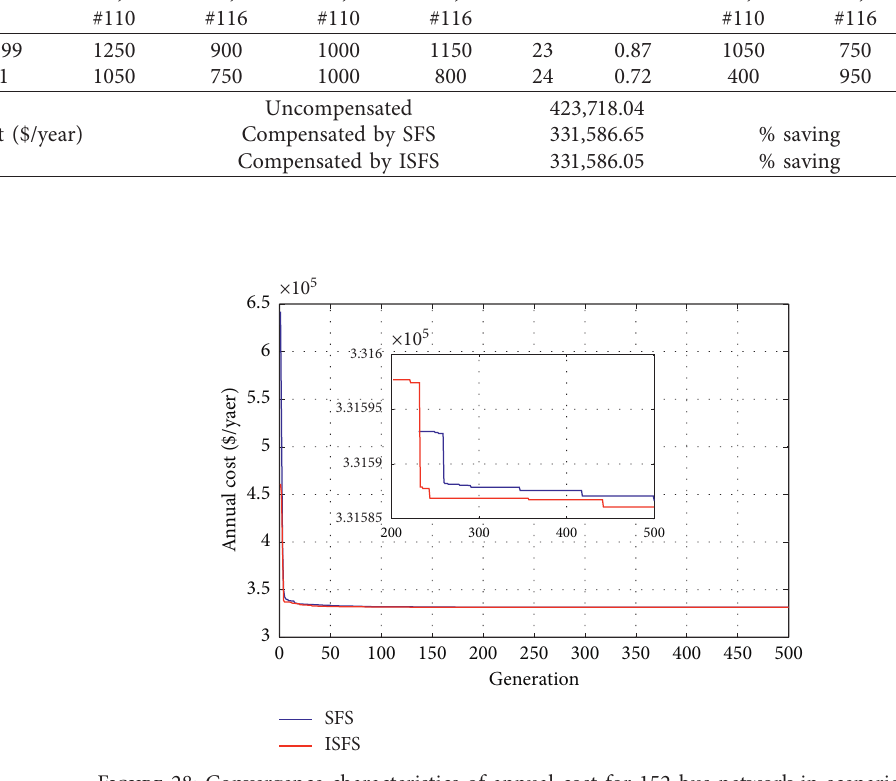
Figure 28: Convergence characteristics of annual cost for 152-bus network in scenario 2.